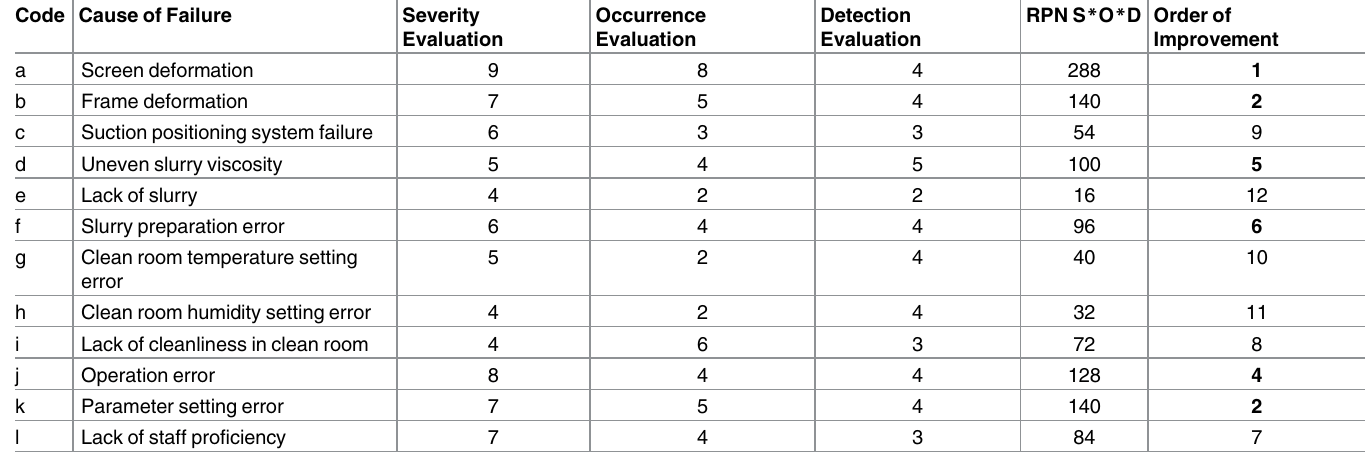
144 grids. Among the 144 grids, the 12 diagonal grids with zero influence were excluded, for a total of 132 grids that represented the mutual influence of the 12 factors. Then, the direct-relation matrix was normalized using the column vectors and maximum values as the baseline, where λ was the maximum value for the sum of each column. Using Eq (2), the values in direct-relation matrix X were multiplied by λ to formulate the normalized direct-relation matrix N (Table 3).